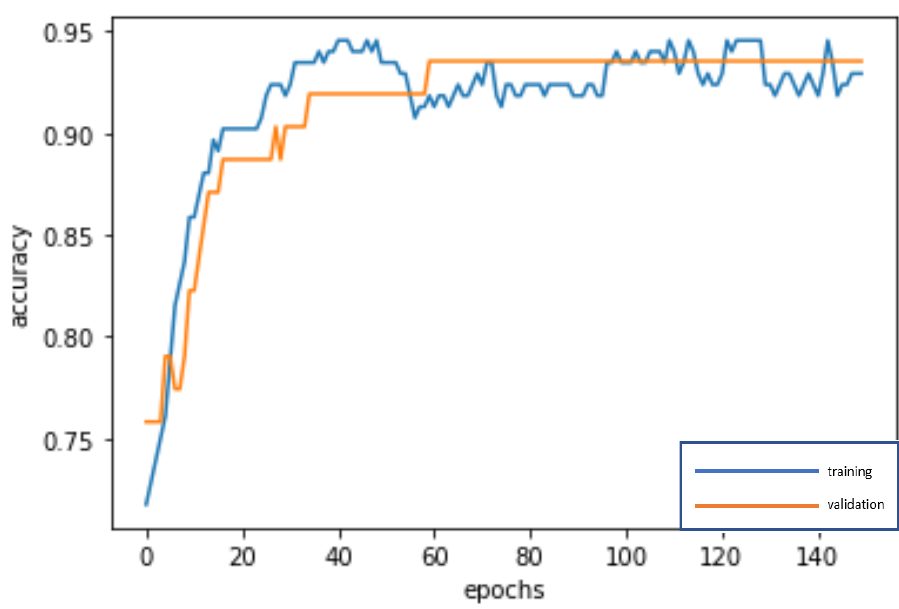
Figure 9. Accuracy line graph of the CART-RNN modeling.